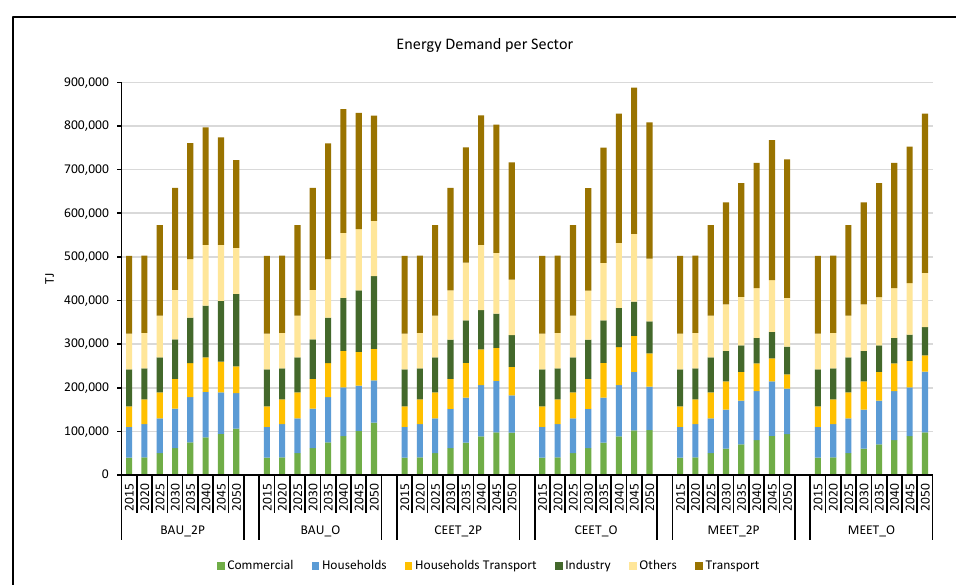
Figure 4. Evolution of energy demand per sector and scenario.